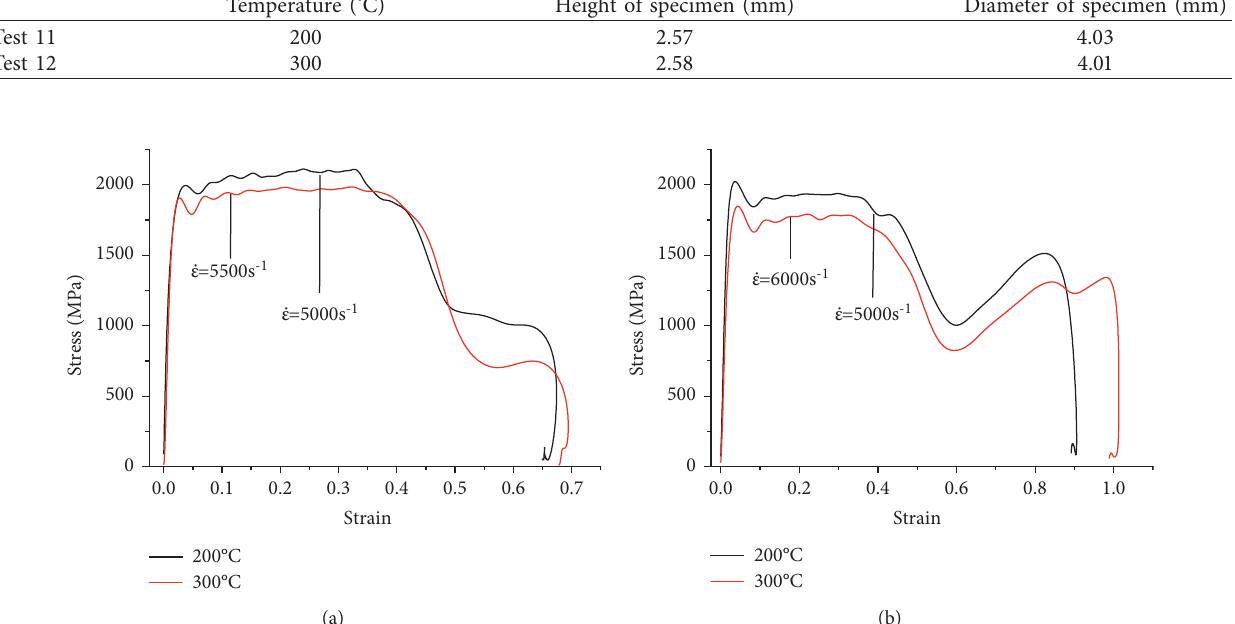
Table 6: Experimental conditions of the dynamic compression of TRIP800 spot welds under heating condition. Temperature ( ° C) Height of specimen (mm) Diameter of specimen (mm)